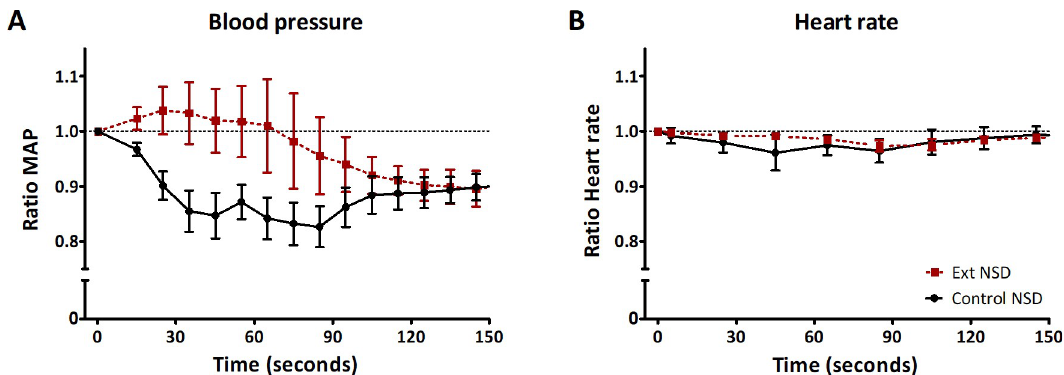
Fig 5. Ext1 +/- Ext2 +/- mice show an abnormal MAP response after acute sodium loading. Control and Ext1 +/- Ext2 +/- mice were subjected to rapid 1.8% NaCl infusion, which was finished at t = 0 seconds. (A) Ext1 +/- Ext2 +/- (n = 5) and control mice (n = 6) showed a significant variation in intracarotid MAP response (Ext1 +/- Ext2 +/- vs control, p = 0.02): control mice had a significant 15 ± 4% (p = 0.02) decrease in MAP, while MAP of Ext1 +/- Ext2 +/- mice did not change (3 ± 6%, p = 0.65). At baseline, MAP was not different whereas heart rate of Ext1 +/- Ext2 +/- mice was significantly higher (421 ± 14 bpm) than in control mice (335 ± 11 bpm, p = 0.005). (B) After infusion, we did not observe any change in heart rate in control (-2 ± 2%) or Ext1 +/- Ext2 +/- mice (-1 ± 1%) (p = 0.49). Ext, Ext1 +/- Ext2 +/- ; NSD, normal sodium